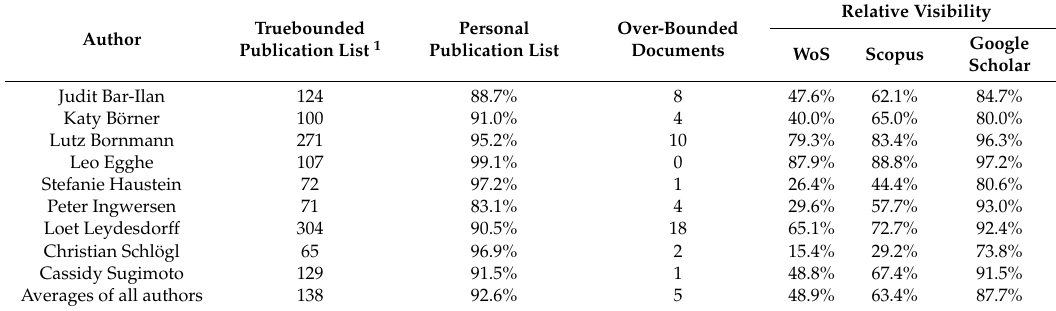
Table 1. Test for underbounded and overbounded publication lists. Investigated authors of the ISSI Scientific Committee and their relative visibility in WoS, Scopus, and Google Scholar as well as in their personal publication